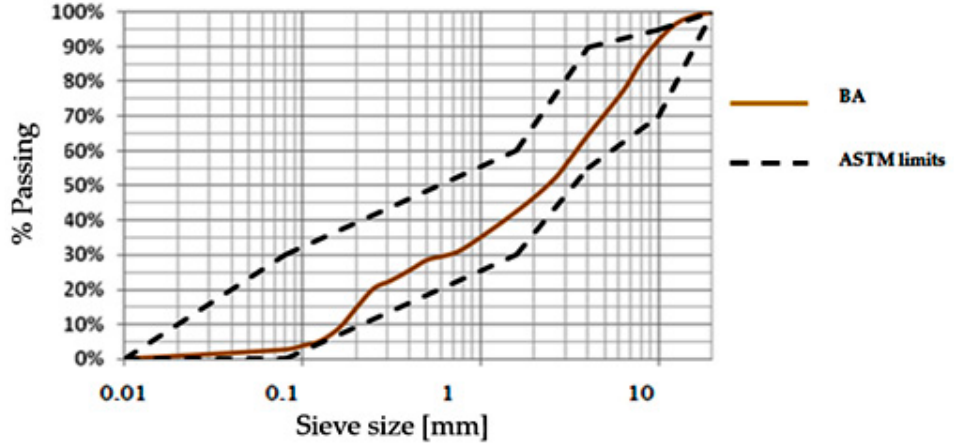
Figure 4. Granulometric curve of JLEC BA.